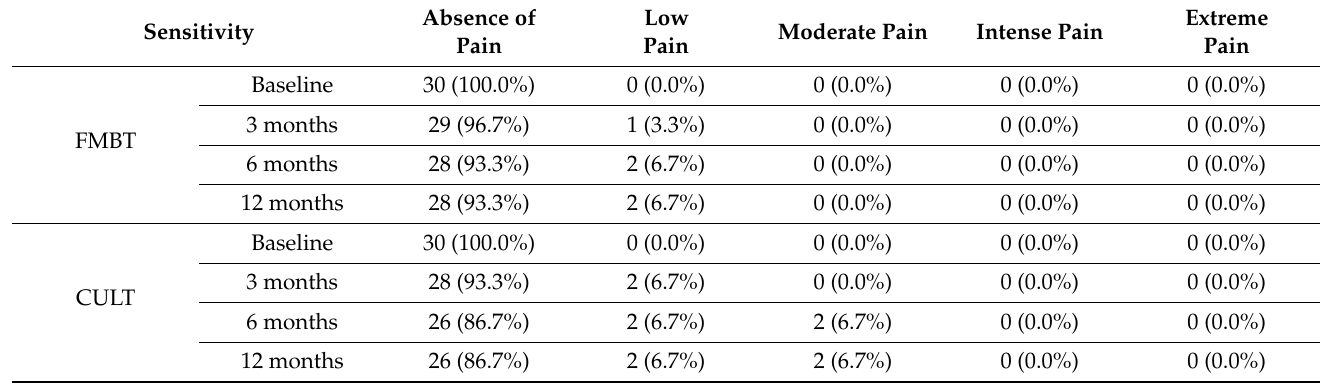
Table 3. Assessment of sensitivity for restored teeth with FMBT and CULT over time ( p > 0.05).